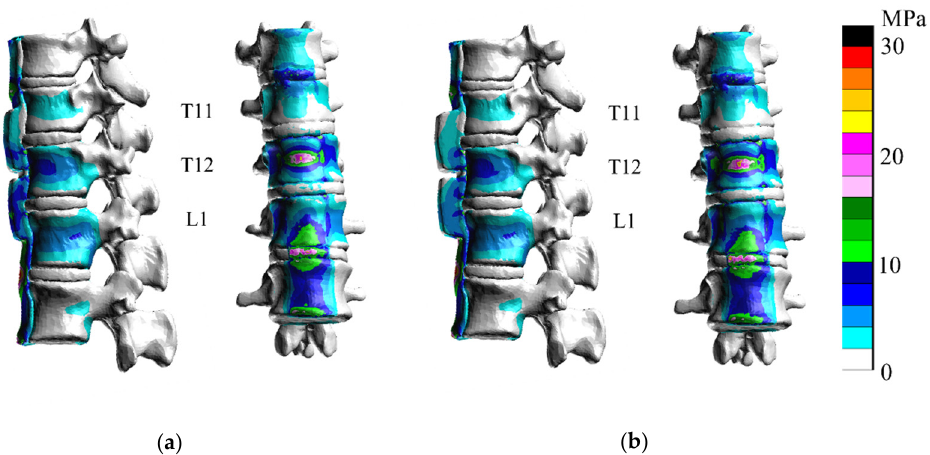
Figure 13. In D-5/R-2.5 ( a ) and D-10/R-2.5 ( b ), the stress at the center of T12 increased at the discontinuity in flexion.